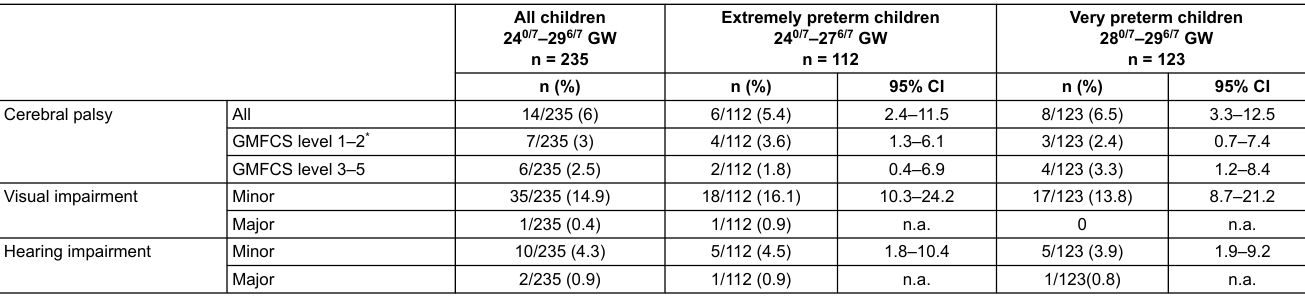
Table 3: Motor and sensory impairment at early school age by gestational age.